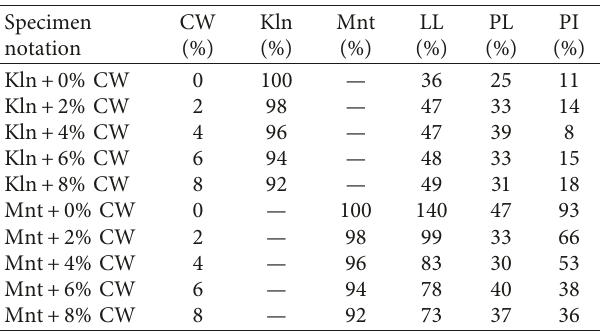
Table 3: Notation used for the mixtures, mixture ratios, and